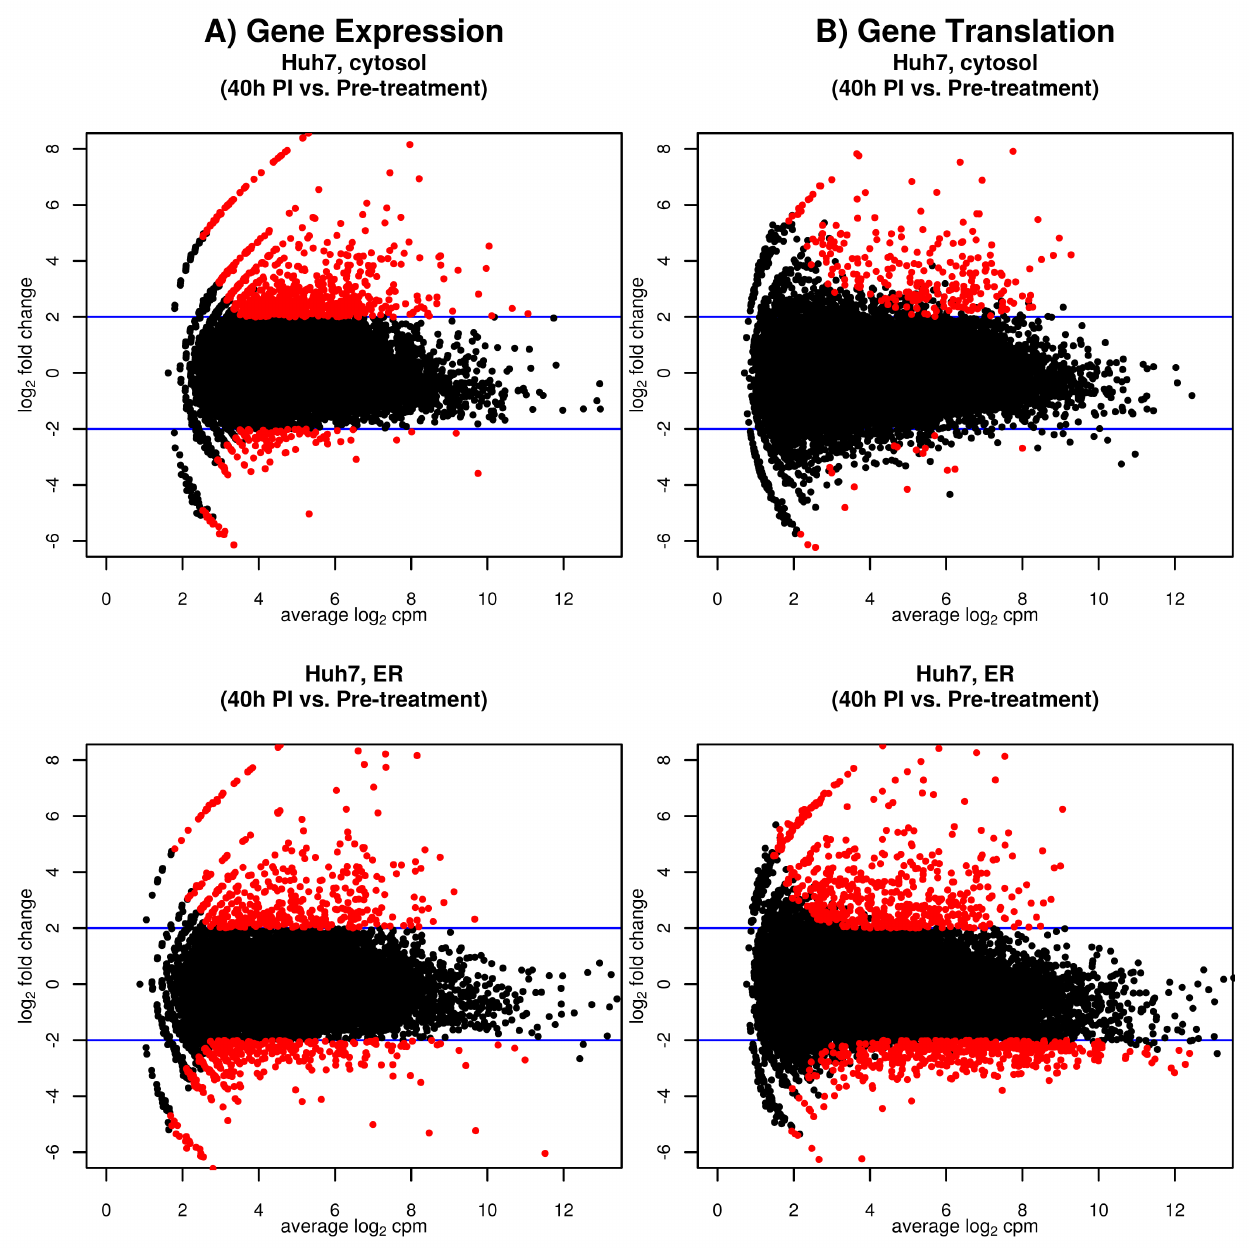
Figure 3. Dengue virus case study: MA plots that contrast log post infection in the cytosol and endoplasmic reticulum (ER). In red: DE/DT genes. CPM: gene expression measured in counts per million. Blue line: fold change cut off (4-fold on the original